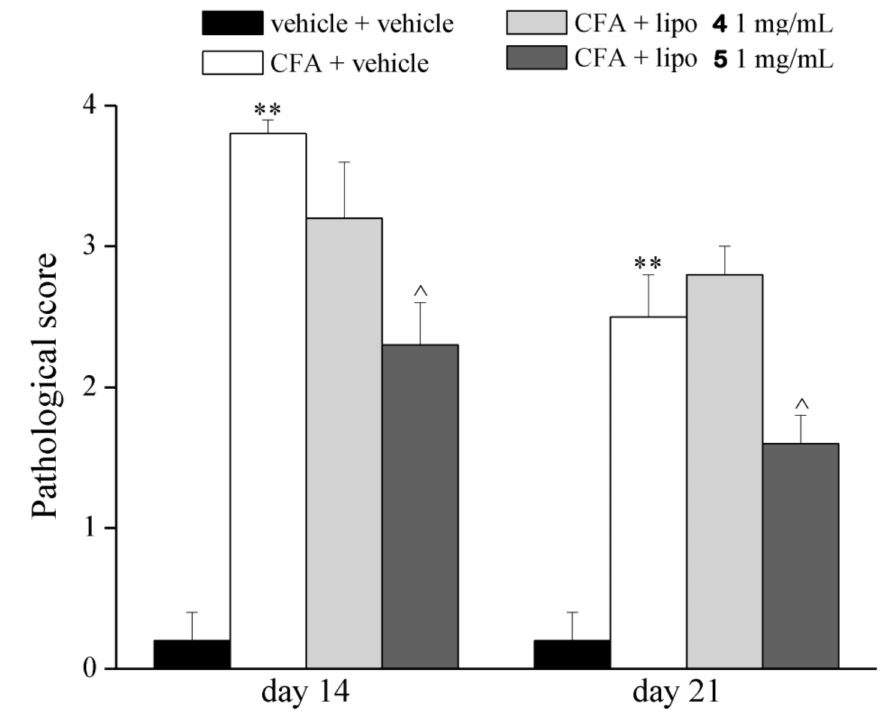
Figure 6. Intra-articular pain reliever e ff ect of lipo 4 and lipo 5 in a CFA i.a. injection-induced RA model in rats. Beam Balance test was used to assess the motor skills of the animals. Results were reported as behavioural score ranging from 0 (normal animals) to 4 (the higher pathological response). Fifty µ L of lipo 4 and lipo 5 (both 1 mg mL − 1 ) were i.a. injected 7 days after CFA. Measurements were performed on day 14 and 21. Control animals were treated with vehicle. The value represent the mean of eight rats performed in two di ff erent experimental sets. ** p < 0.01 vs. vehicle + vehicle-treated animals; ˆ p < 0.05 and ˆˆ p < 0.01 vs. CFA + vehicle-treated